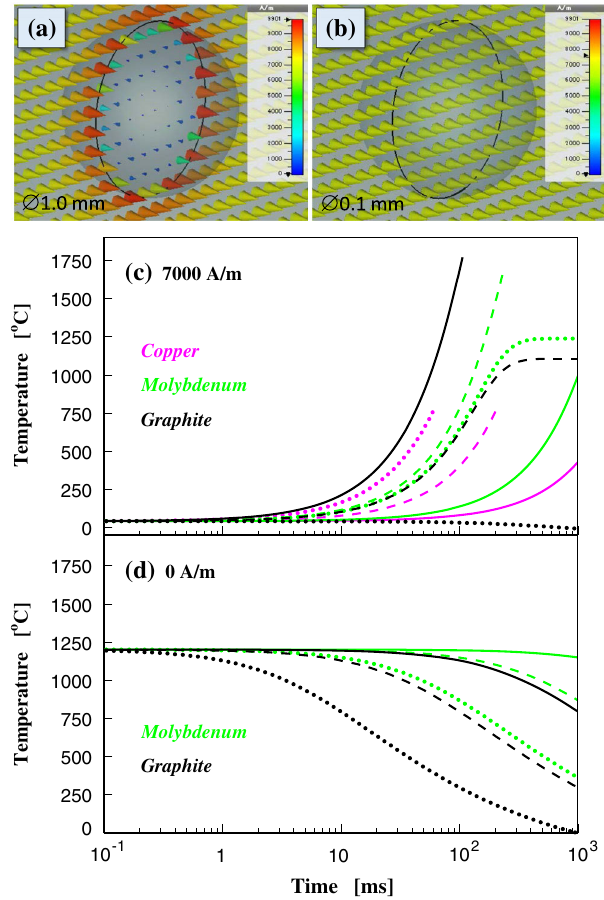
FIG. 22. Simulations of temperatures of spherical micropar- ticles made of graphite (black lines), molybdenum (green lines), and copper (magenta lines) with diameters of 1.0 mm (solid lines), 0.1 mm (dashed lines), and 0.01 mm (dotted lines) located in a vacuum. Radiation cooling was calculated according to the Stefan – Boltzmann law with an emissivity of 0.8 for graphite and 0.1 for copper and molybdenum. Heat capacities of 0.71, 0.39, and 0 . 28 kJ = K = kg were used for graphite, copper, and molyb- denum, respectively. (a) and (b) Application of a 508.9-MHz magnetic field of 7000 A = m to graphite microparticles with diameters of 1.0 and 0.1 mm, respectively, assuming an electric conductivity of 1 . 0 × 10 5 S = m for graphite. (c) Temperature variation of the microparticles from an initial temperature of 40 °C with heat generation by a magnetic field of 7000 A = m. (d) Temperature variation of the microparticles from an initial temperature of 1200 °C without heat magnetic field of 7000 A = m in a vacuum. Data above the sublimation points at 2 × 10 − 5 Pa ( 1770 °C for graphite, 1700 °C for molybdenum, and 800 °C for copper) are excluded. The selected magnetic field strength of 7000 A = m is roughly equivalent to the strength of the field applied to the bright spot BS-A1 at V c ¼ 0 . 95 MV.